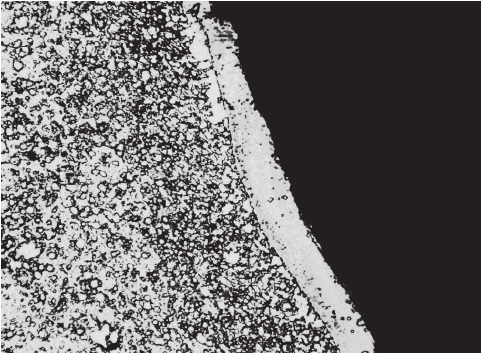
Figure 5: Optical micrograph of modified HS 6-5-2 steel surface at 200 V for 3 min, 800x .